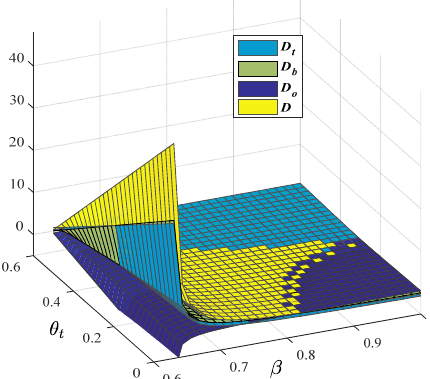
Figure 10. Demand in Scenario D (1).